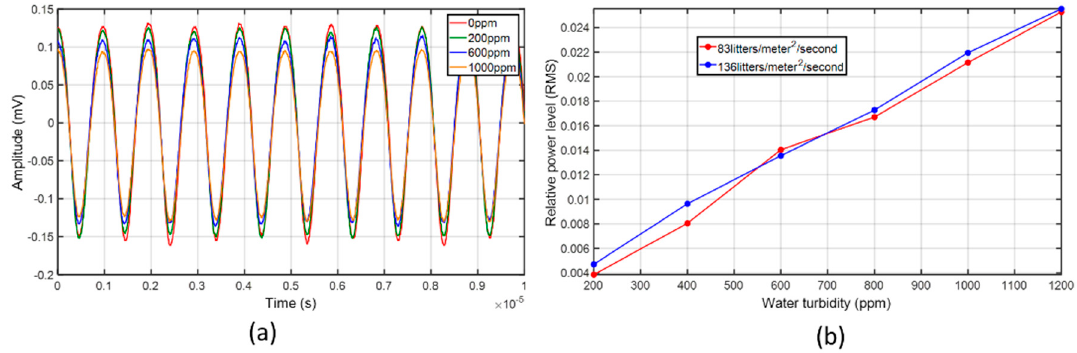
Figure 3. ( a ) Received signals at turbidity levels of 0, 200, 600, and 1000 ppm and at water a flow velocity of 83.14 q ; ( b ) water turbidity levels versus ∆ RMS values.